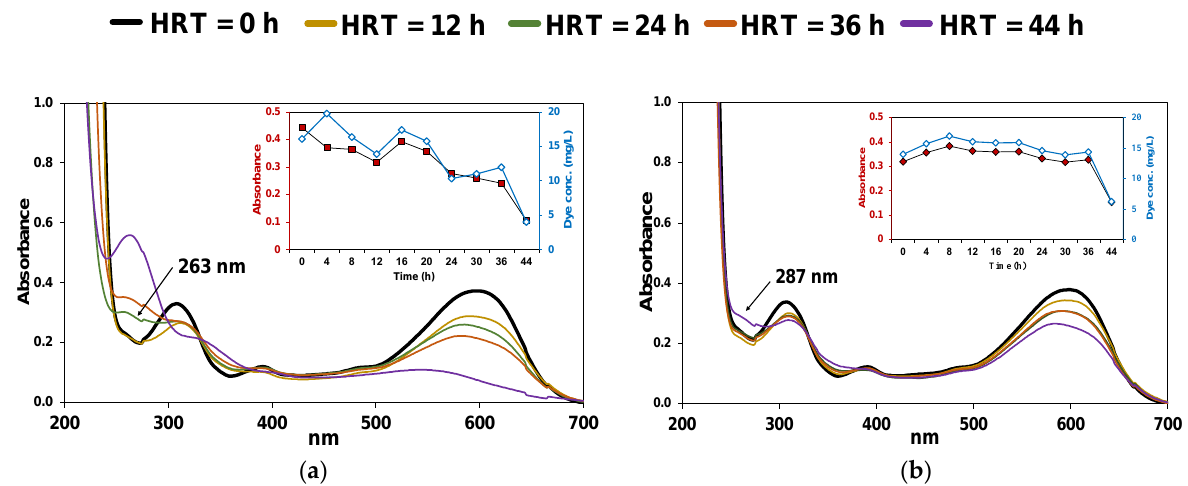
Figure 6. Time-overlaid UV-vis spectra for samples collected at 15 mg/L of RB-5 influent feeding in ( a ) reactor A and ( b ) reactor B; (inset) decrease in absorption at λ max = 597 nm as a function of treatment period from run 3 .